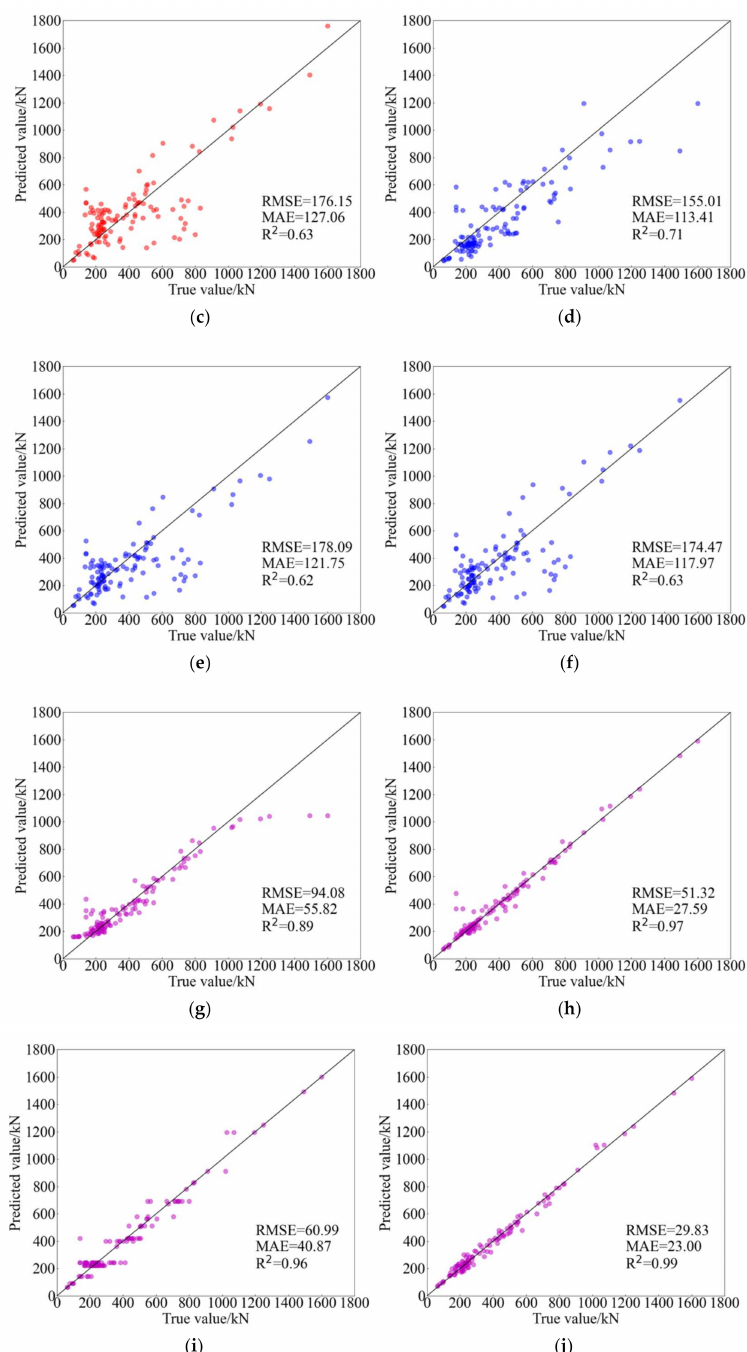
Figure 8. The predictions of models for the whole data set. ( a ) Formula (1); ( b ) Formula (2); ( c ) Formula (3); ( d ) Formula (4); ( e ) Formula (5); ( f ) Formula (6); ( g ) ANN; ( h ) PSO-SVR; ( i ) DT; ( j )